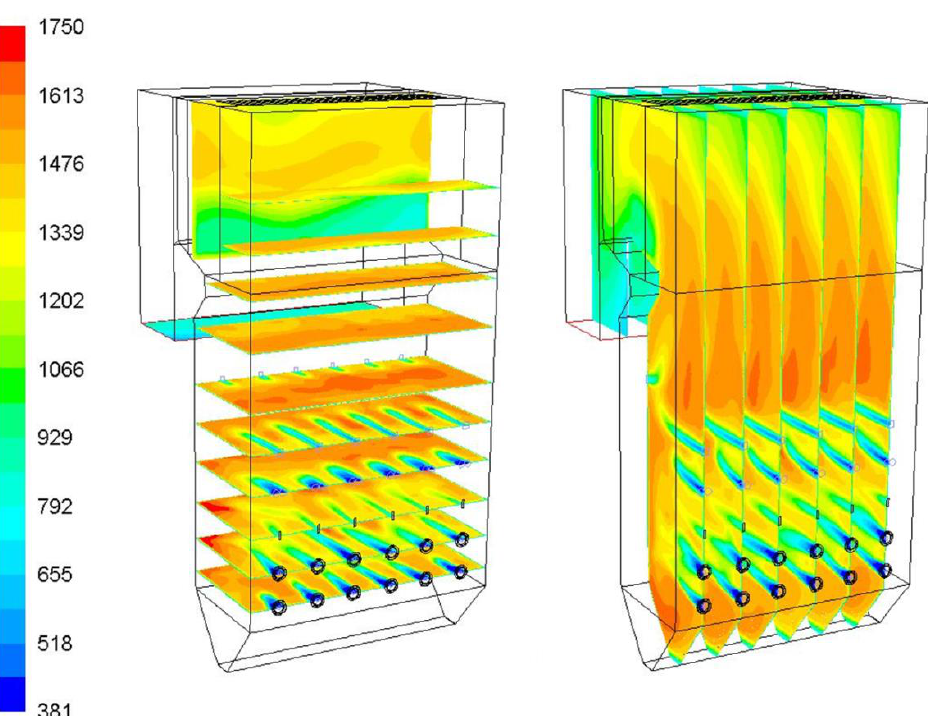
Figure 7. Temperature distribution (K) in the planes of the burner axis.